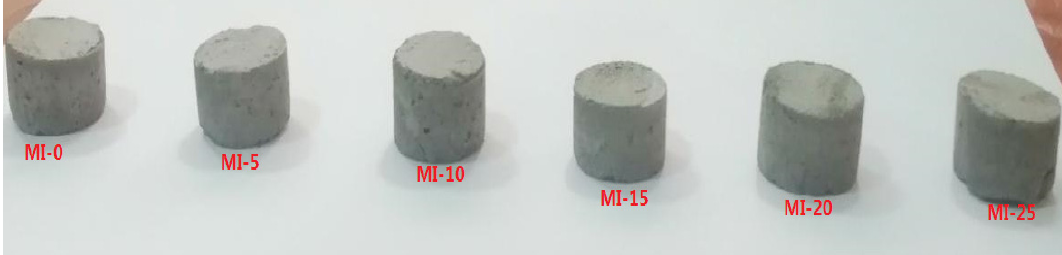
Figure 1. The mortar samples used in the radiation attenuation measurements.